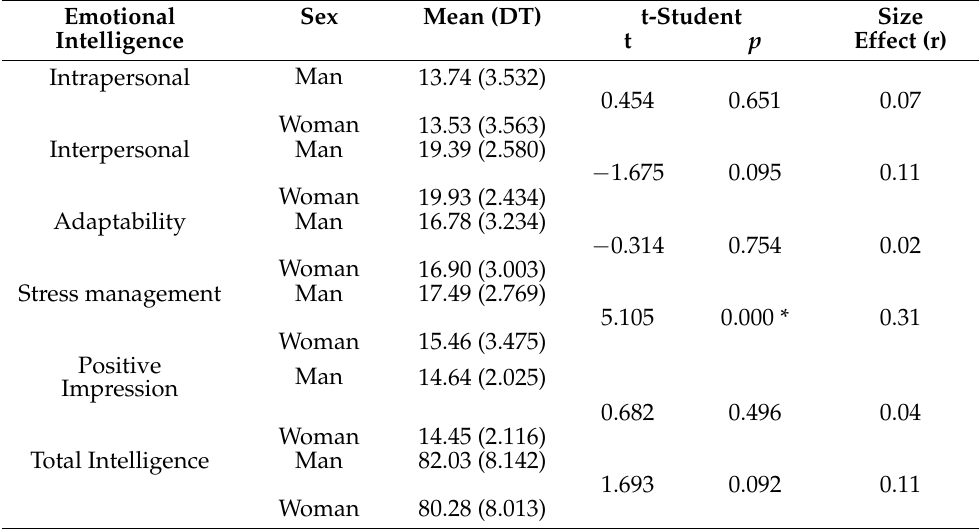
Table 3. Differences between men and women in Emotional Intelligence.